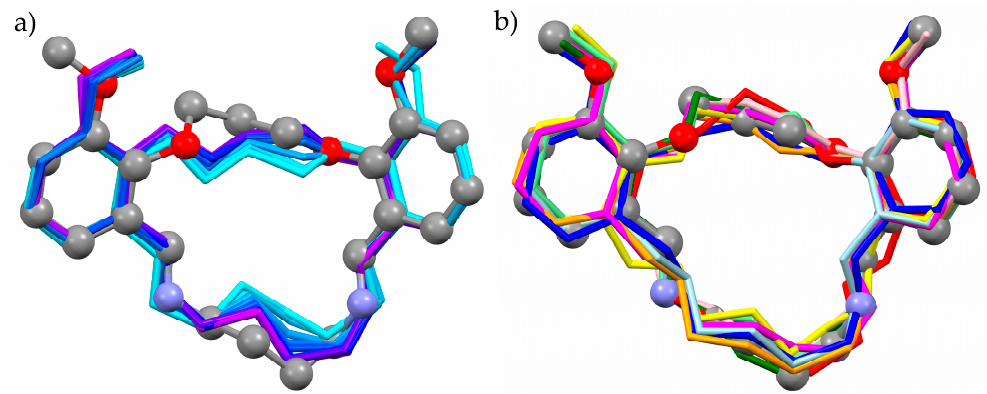
Figure 6. ( a ) Overlay of results found by the default setting of the parallel tempering algorithm without MD approach. Evolution of the conformation towards the correct one is clearly visible from the changing colour of the first (light blue) to the last (purple) result. ( b ) Overlay of results found by the MD approach. One-coloured stick styles represent results suggested by the described optimization process combined with MD moves. The picture shows that atomic positions suggested by the optimization method are distributed around the correct atomic positions. Ball style with different atomic colours represents the published solution in both parts of the picture.